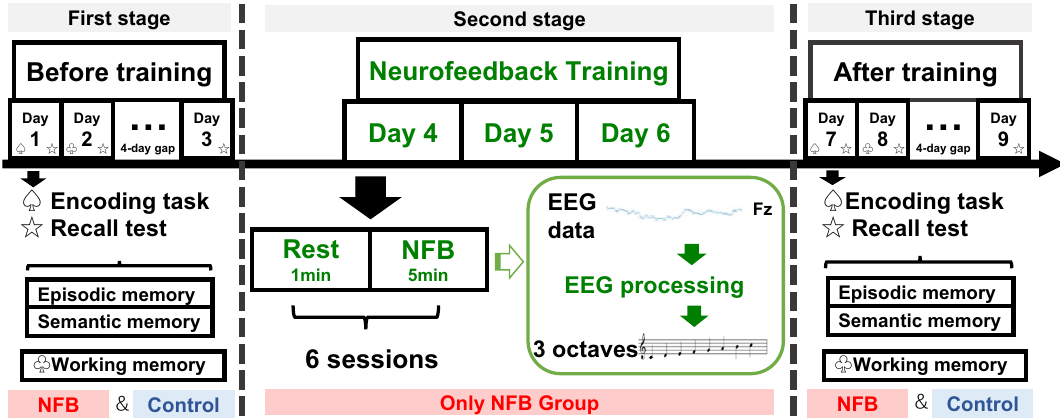
Figure 5. Study procedure. The study included three stages: before training, neurofeedback (NFB) training, and after training. The NFB group performed all three stages, and the control group performed the first and third stages. The first and third stages followed the same design, though the tasks differed. On days 1 and 7, participants performed the encoding tasks for both episodic and semantic memory, then performed the recall tests for both episodic and semantic memory after a 20-min wait. On days 2 and 8, participants performed the recall test for both episodic and semantic memory, then they performed the working memory task. On days 3 and 9, the participants performed another recall test for both episodic and semantic memory. This third recall test was completed after a 4-day gap. In the second stage, participants in the NFB group underwent 3 days of NFB training. One session consisted of a 1-min rest period and 5 min of auditory NFB training. There were six sessions on each training day. This figure was drawn using Microsoft PowerPoint for Mac (version